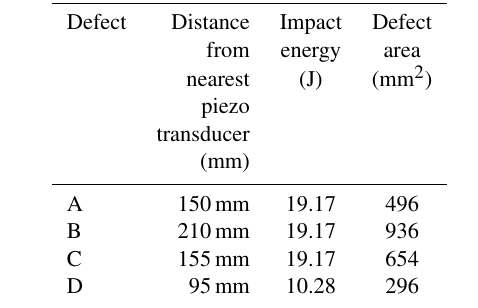
Table 1. Distance from the nearest piezo and defect area for an impacted specimen.